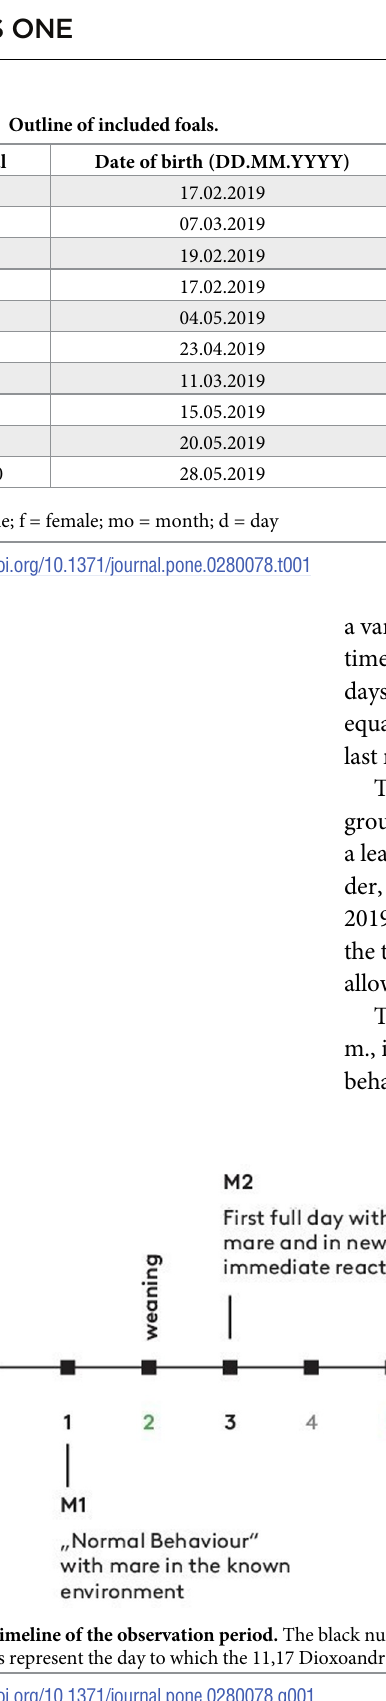
Table 1. Outline of included foals.